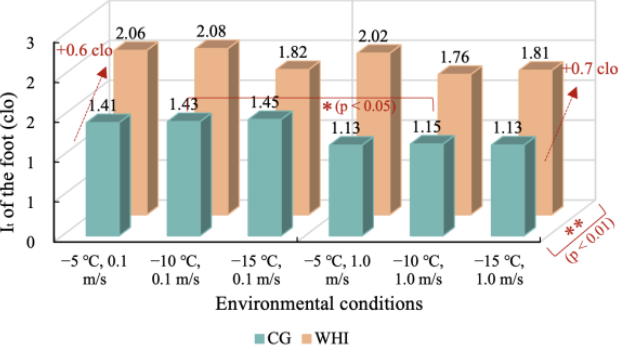
Figure 12. I t, foot of CG and WHI in different environmental conditions.